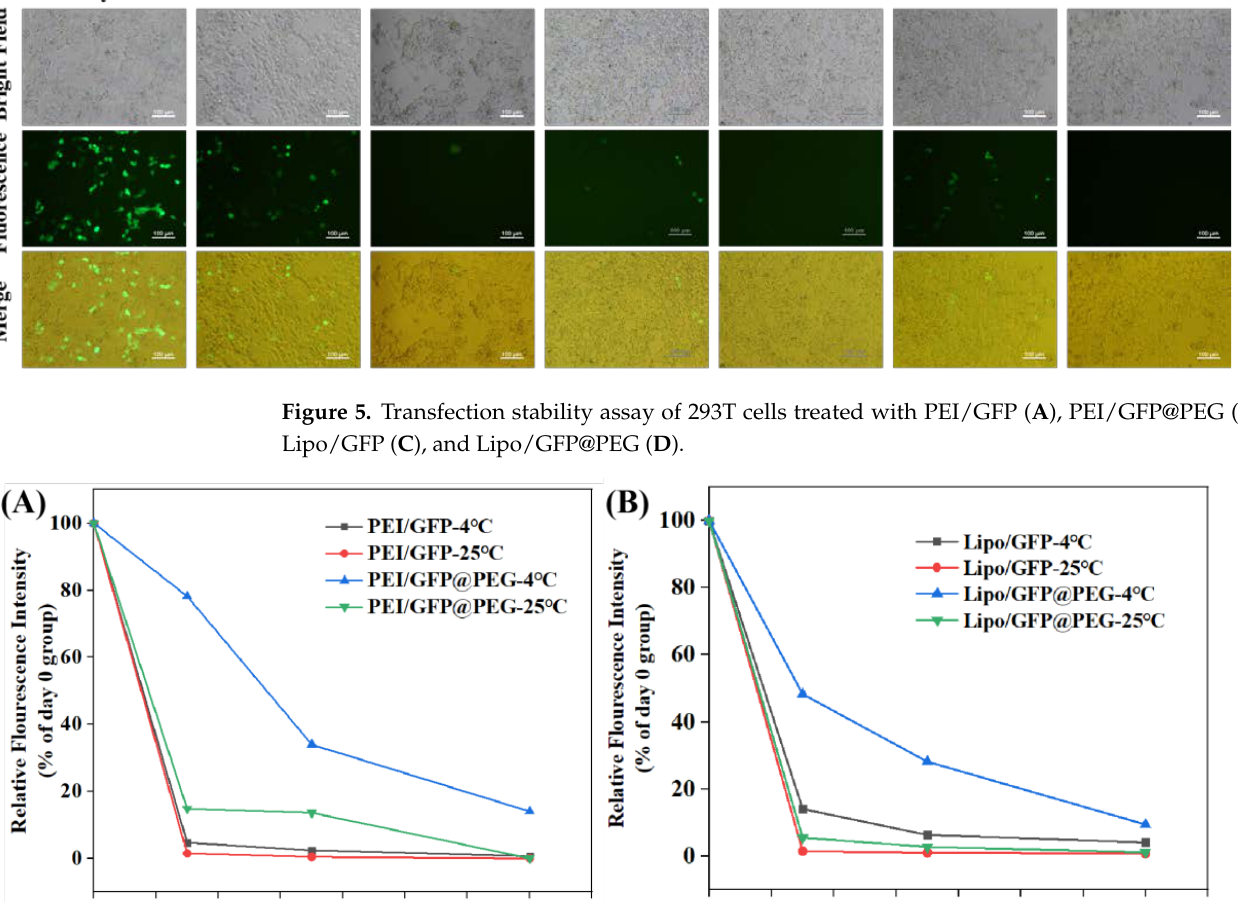
Figure 6. Flow quantitative results of 293T cell transfection with PEI/GFP, PEI/GFP@PEG ( A ), and Lipo/GFP, Lipo/GFP@PEG ( B ).